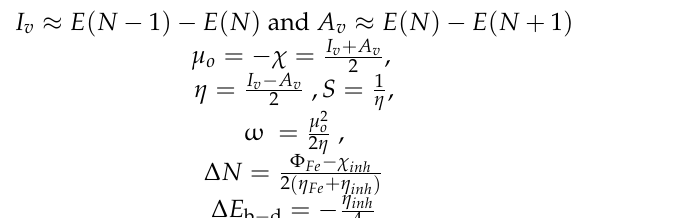
Scheme 1. Chemical structures of the TGP (neutral ( left ) and protonated ( right )). The numbers do not follow the IUPAC system.